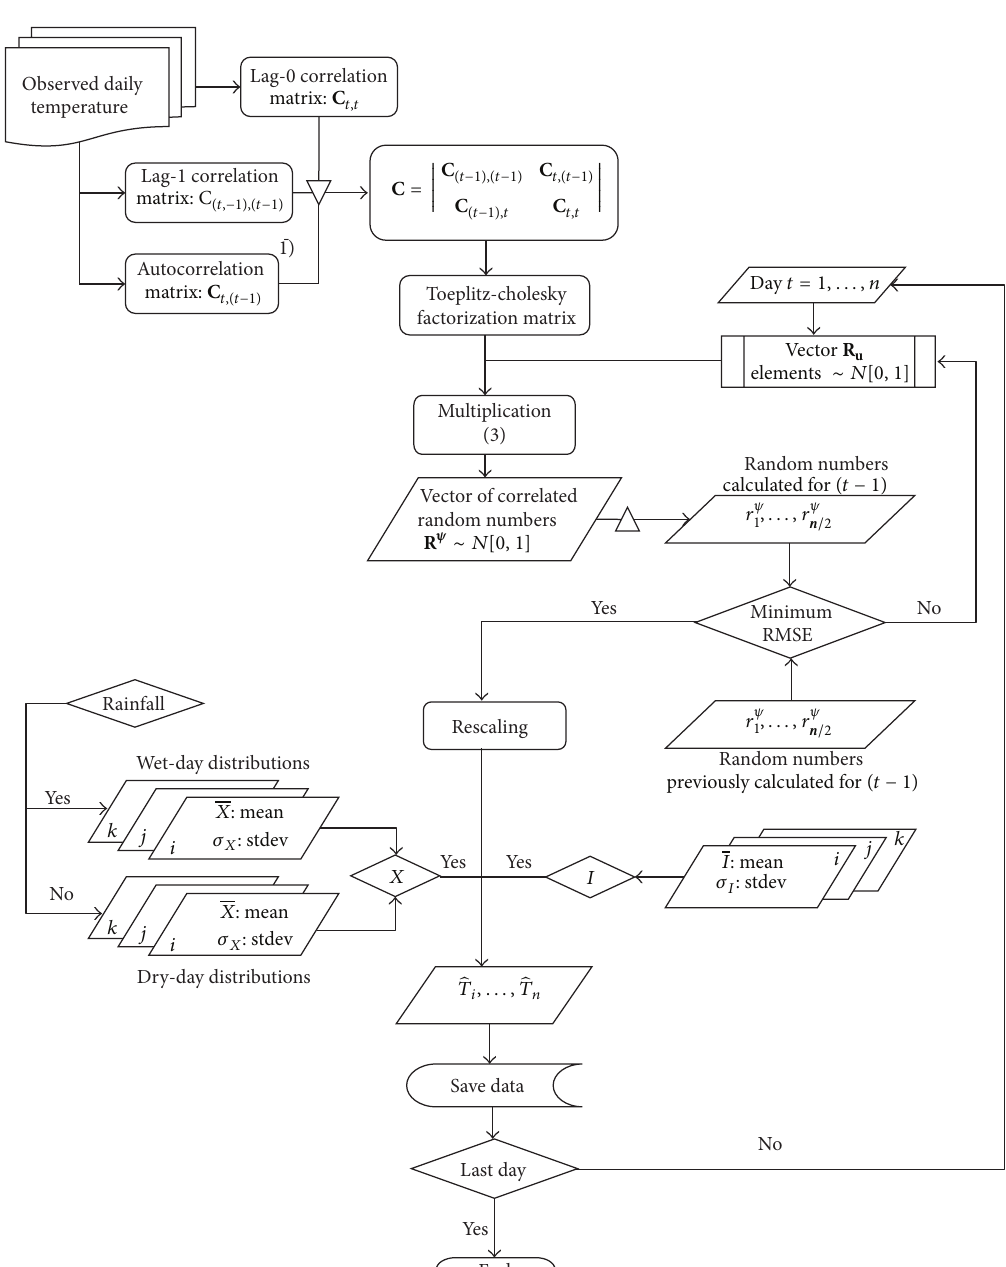
Figure 2: Flow diagram detailing the sequence of processes to generate maximum and minimum temperatures following the second model.